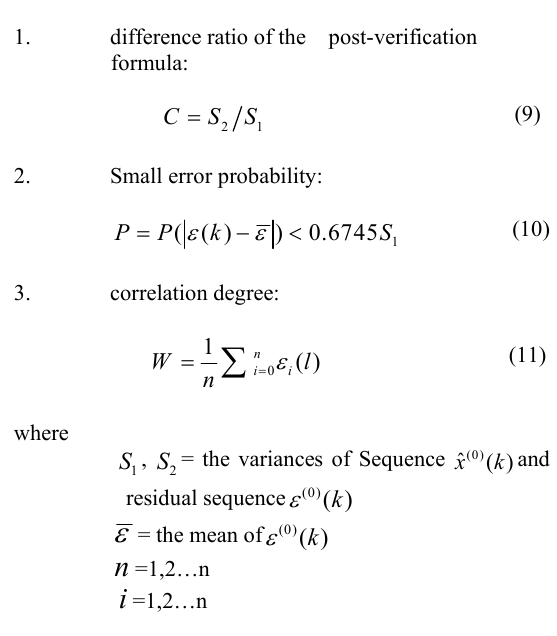
As the growth of the time and the instability of the ionosphere TEC itself will lead to the grey model GM (1, 1) prediction accuracy cannot be guaranteed, in order to improve the prediction precision of GM (1, 1) model, in this paper, the prediction accuracy is not high residual error of the grey model to predict the results of correction, establish the residual value of GM (1, 1) model and residual error GM (1, 1) model for short. The forecast value of residual GM (1,1) model is used